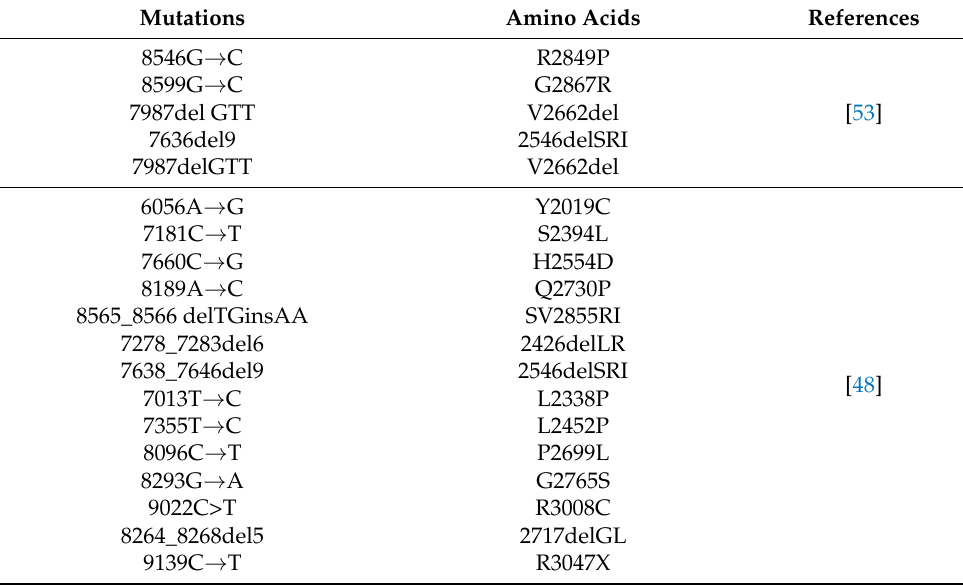
Table 2. ATM kinase dead mutations identified in A-T patients and modeled in A-T cell lines. Mutations Amino